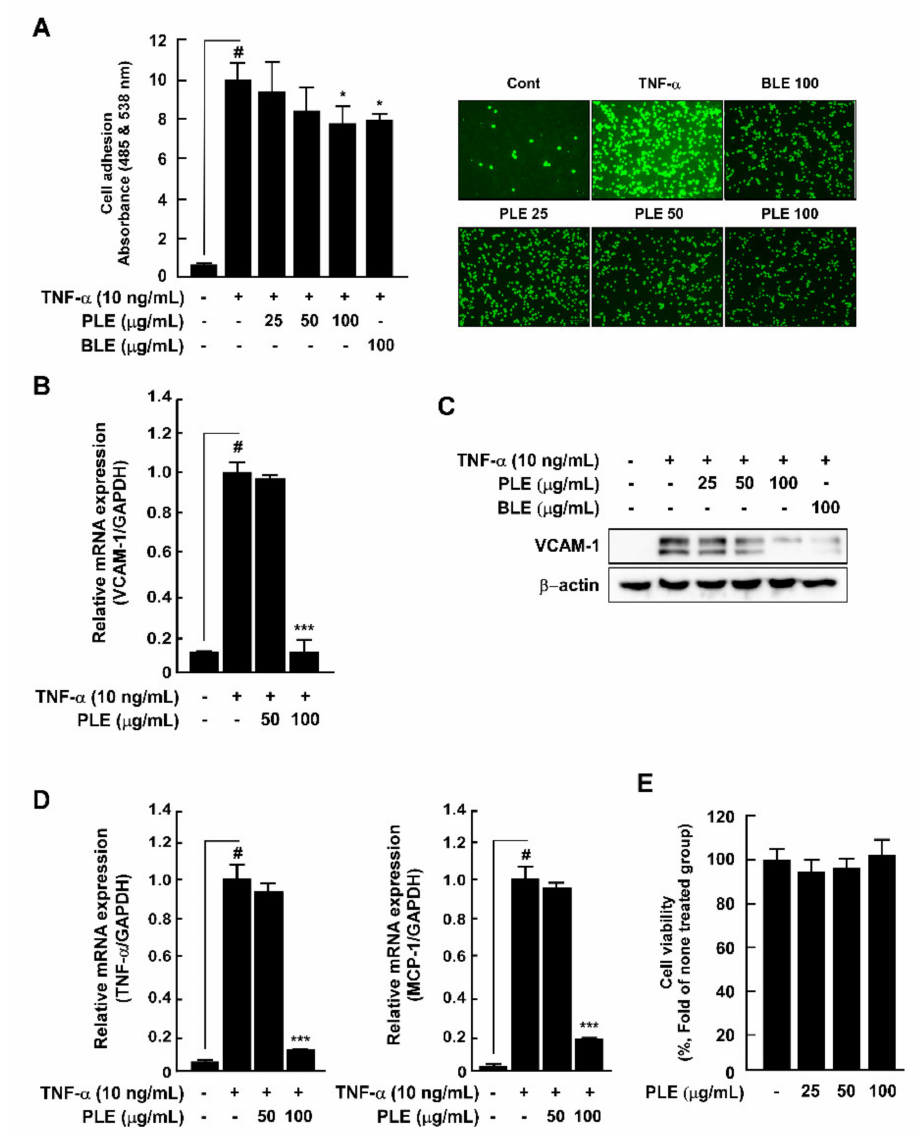
Figure 1. Paeonia lactiflora extract (PLE) ameliorated tumor necrosis factor (TNF- α )-induced monocyte adhesion capacity and inhibited vascular cell adhesion molecule (VCAM-1), TNF- α , and monocyte chemoattractant protein-1 (MCP-1) expression in human umbilical vein endothelial cells (HUVECs). ( A ) THP-1 cell adhesion to HUVECs after treatment with PLE and TNF- α . Fluorescently labeled THP-1 cells were assessed using fluorescent microscopy. ( B ) mRNA expression levels of VCAM1 in HUVECs after PLE and TNF- α treatment for 24 h. ( C ) TNF- α -induced VCAM-1 expression in HUVECs after PLE and TNF- α treatment assessed using Western blotting. ( D ) TNFA and CCL2 mRNA expression levels after PLE and TNF- α treatment assessed using qRT-PCR. ( E ) Cytotoxicity was evaluated using the MTT assay. # p < 0.05, compared with the control group; * p < 0.05 and *** p < 0.001, compared with the group exposed to TNF- α alone. Data are presented as the mean ± standard deviation of three independent